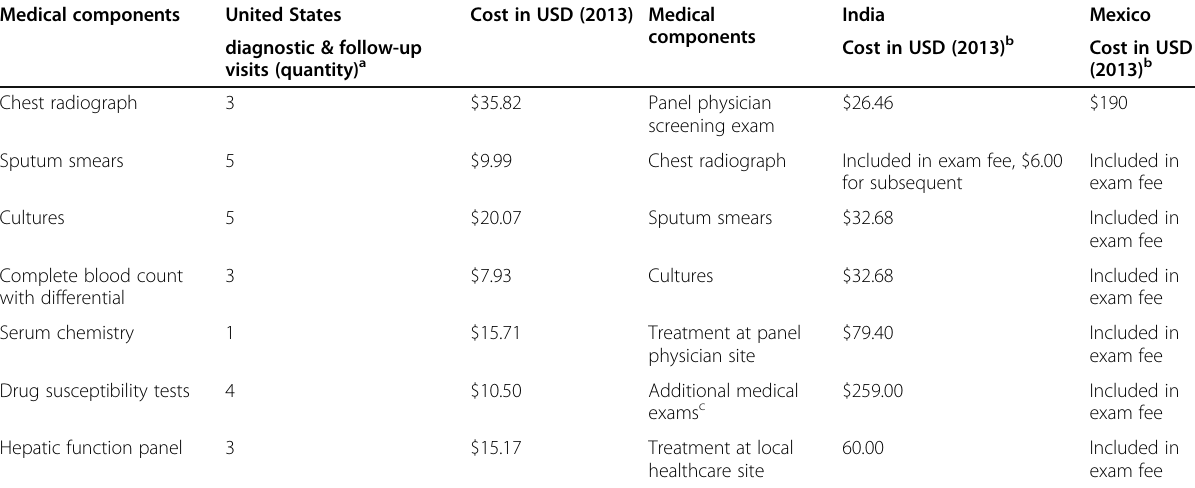
Table 2 Costs of tuberculosis medical exam and treatment for visa applicants, by country Medical